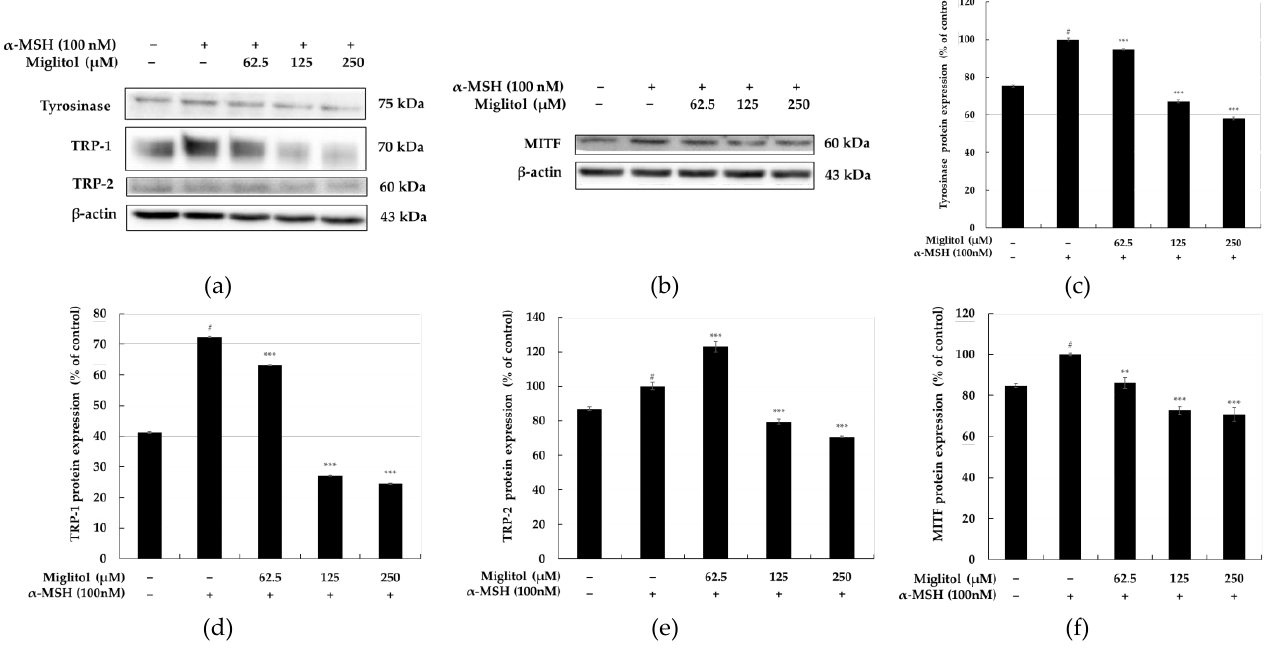
Figure 4. The effect of miglitol on tyrosinase, TRP-1, TRP-2, and MITF protein levels in α -MSH-stimulated B16F10 cells. Cells were treated with miglitol ( 62.5, 125, and 250 μM ) for 48 h in the presence of α -MSH (100 nM). ( a , b ) Western blotting results and ( c ) tyrosinase, ( d ) TRP-1, ( e ) TRP-2 protein expression, and ( f ) MITF protein expression. α -MSH was used as the negative control. The results are presented as the mean ± SD from three repeated measurements using ImageJ. # p < 0.001 vs. the unstimulated control group; ** p < 0.01 and *** p < 0.001 vs. α -MSH alone.